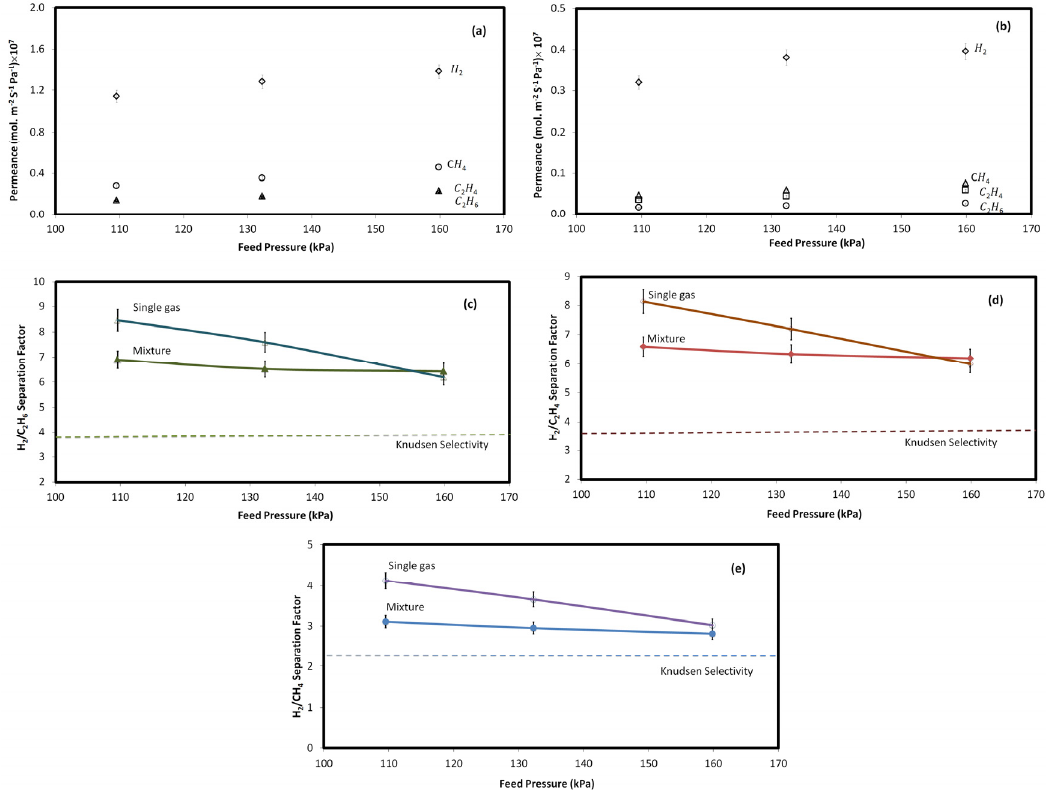
Figure 3. Permeance of ( a ) single gas and ( b ) mixed gas, and selectivity values for ( c ) H 2 /C 2 H 6 , ( d ) H 2 /C 2 H 4 , and ( e ) H 2 /CH 4 in multicomponent (closed symbols) and single gas (open symbols) permeation tests at different feed pressures, as well as at constant temperature (25 °C) and permeate pressure (101.3 kPa).